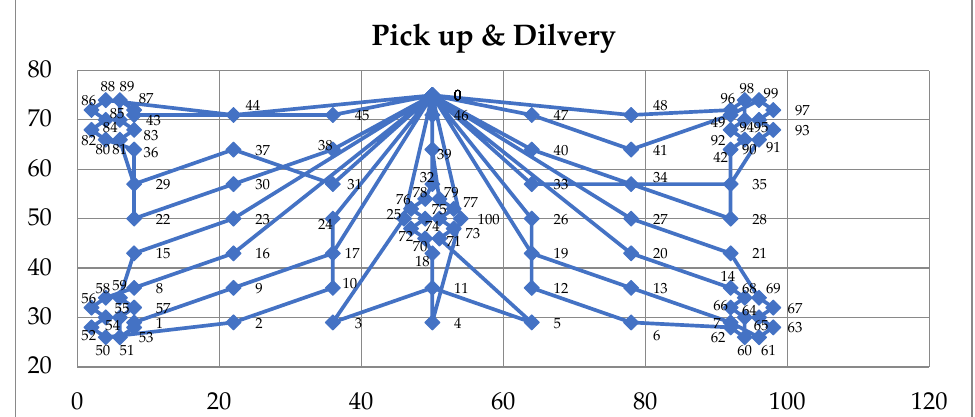
Figure A3. Optimized pickup and delivery routes from sAIS for instance 53P1.